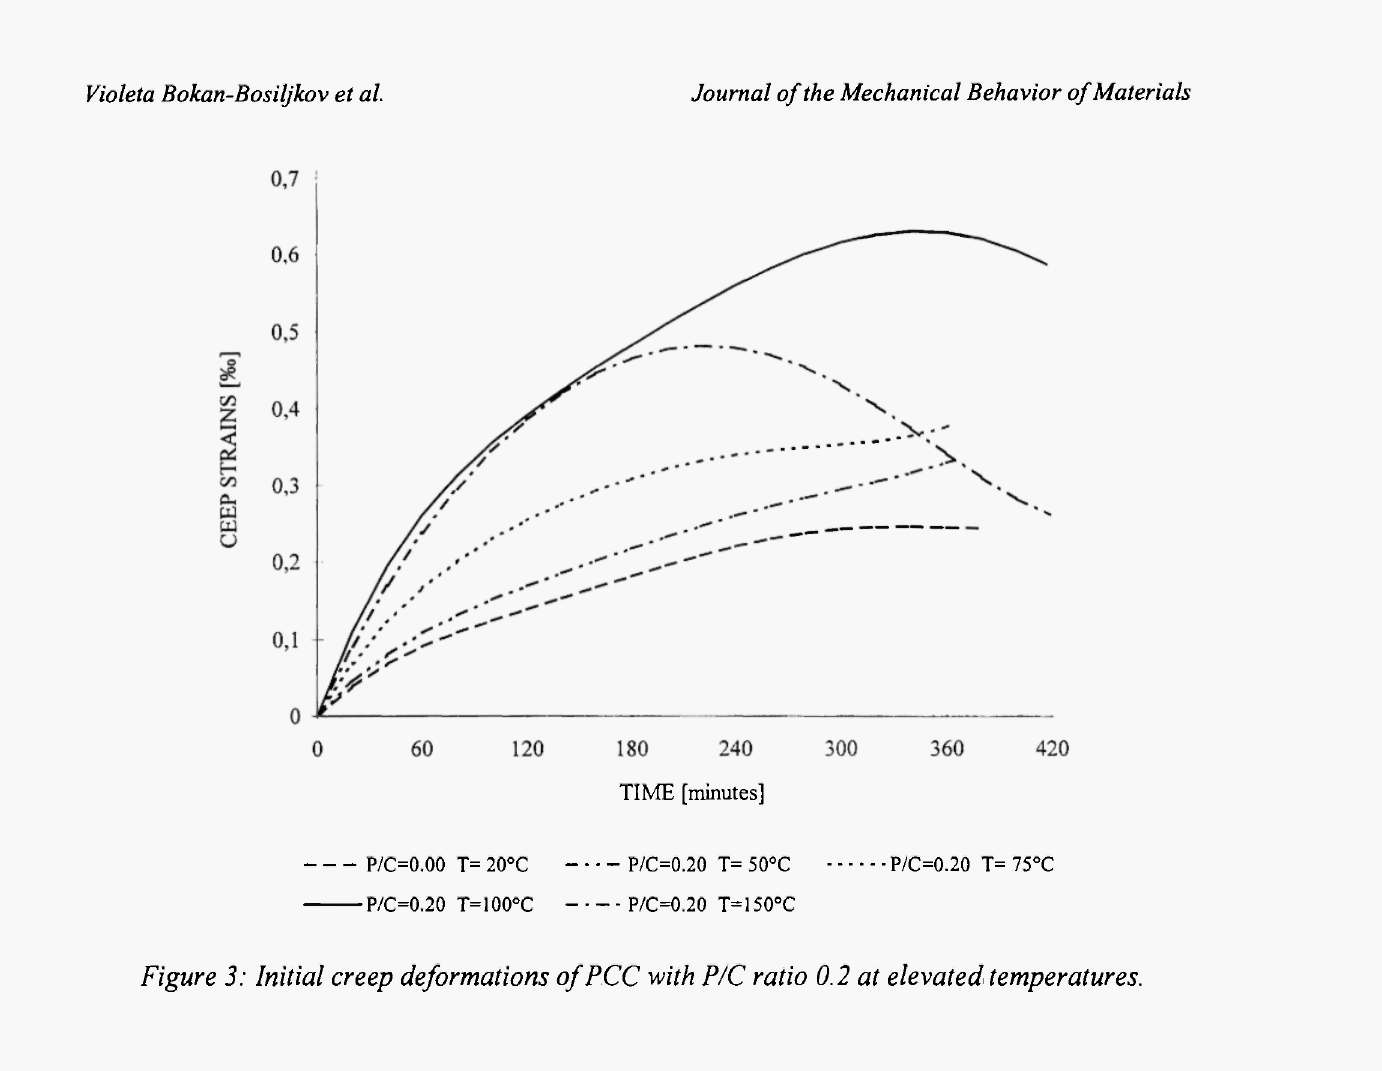
Figure 3: Initial creep deformations ofPCC with P/C ratio 0.2 at elevated